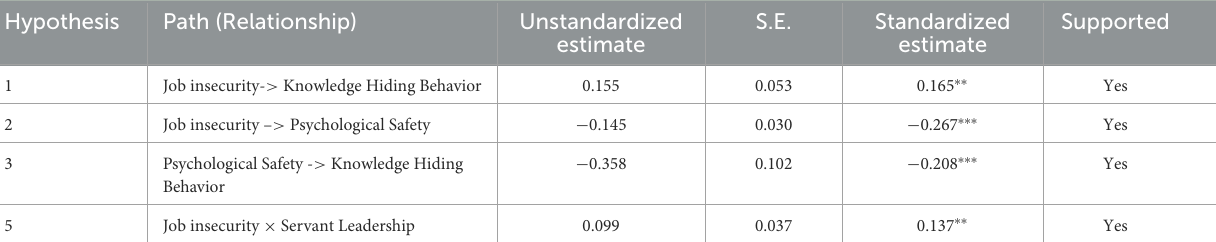
TABLE 3 Results of structural